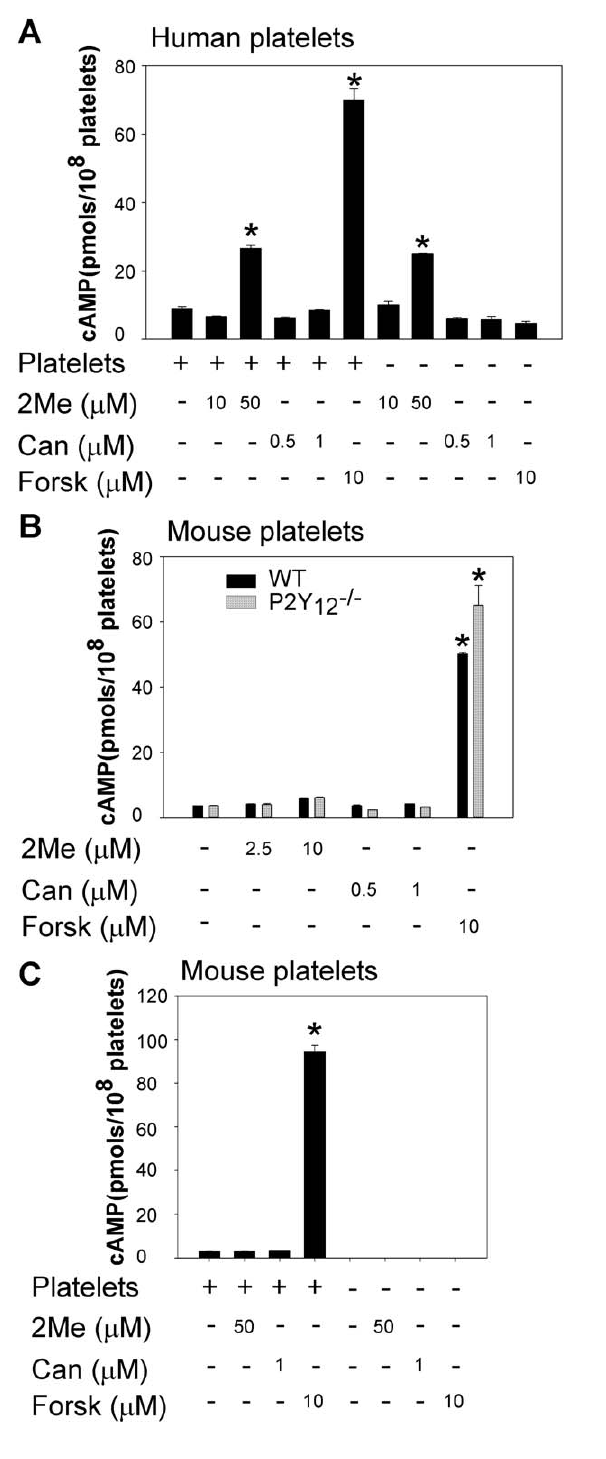
Figure 2. 2MeSAMP and Cangrelor failed to stimulate cAMP production. (A) Washed human platelets were incubated with 2MeSAMP (2Me), Cangrelor (Can), or forskolin (Forsk) at 37 u C for 5 min. The reactions were stopped by the addition of an equal volume of 12% (w/v) trichloroacetic acid. cAMP concentrations were de- termined by using a cAMP immunoassay kit. Statistical differences were examined by Student t test. Data are mean 6 SD. * P , 0.005 versus platelets in the absence of antagonists and forskolin. (B) Washed platelets from P2Y 12 deficient mice or wild-type controls were pre- incubated with 2MeSAMP, Cangrelor, or forskolin for 5 min.